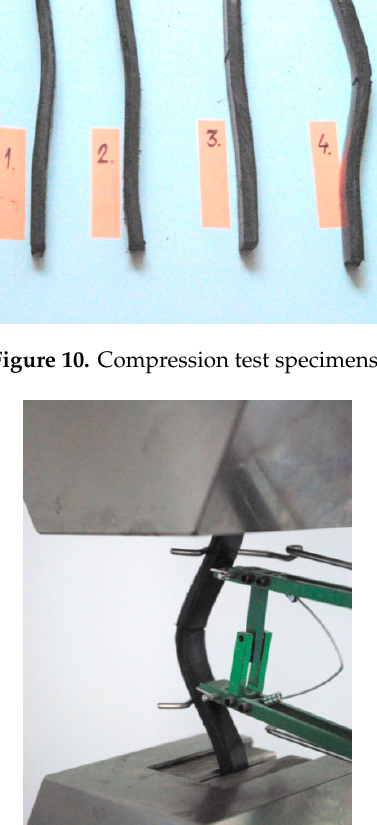
Figure 11. Extensometer used.